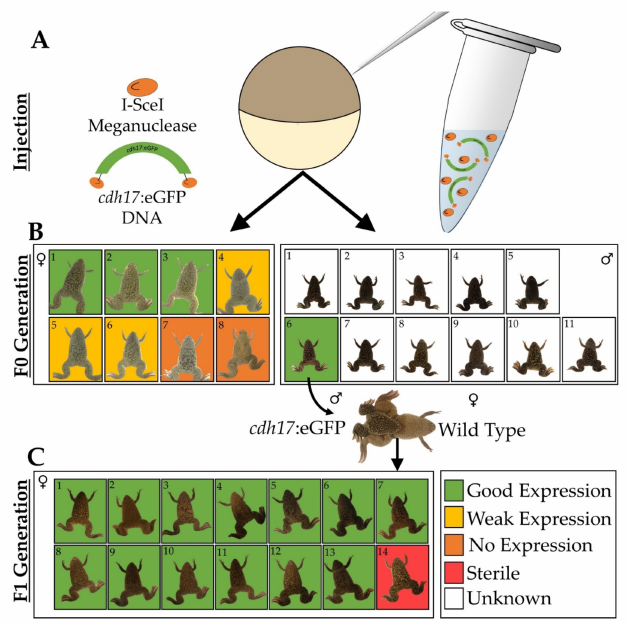
Figure 1. Schematic of cdh17 :eGFP transgenic line creation. ( A ) cdh17 :eGFP construct flanked by I-SceI sites was co-injected with I-SceI meganuclease into one-cell embryos. ( B ) Eight female and 11 male Xenopus laevis adults were grown from these F0 embryos. ( C ) Upon mating of an F0 transgenic male to a wild type female, 14 F1 females were